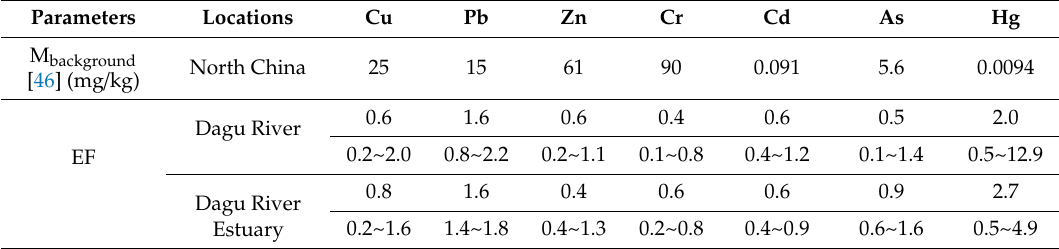
Table 3. Background values and enrichment factors (EF) of heavy metals and metalloids in the Dagu River Estuary.